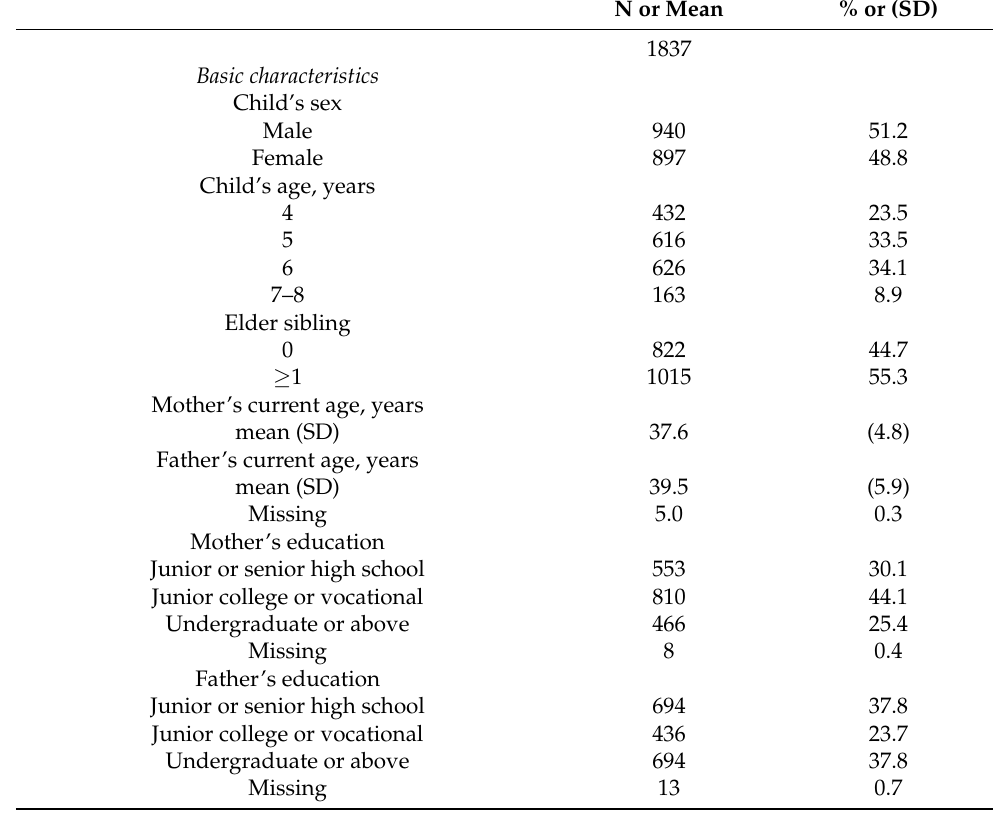
Table 1. Characteristics of children and